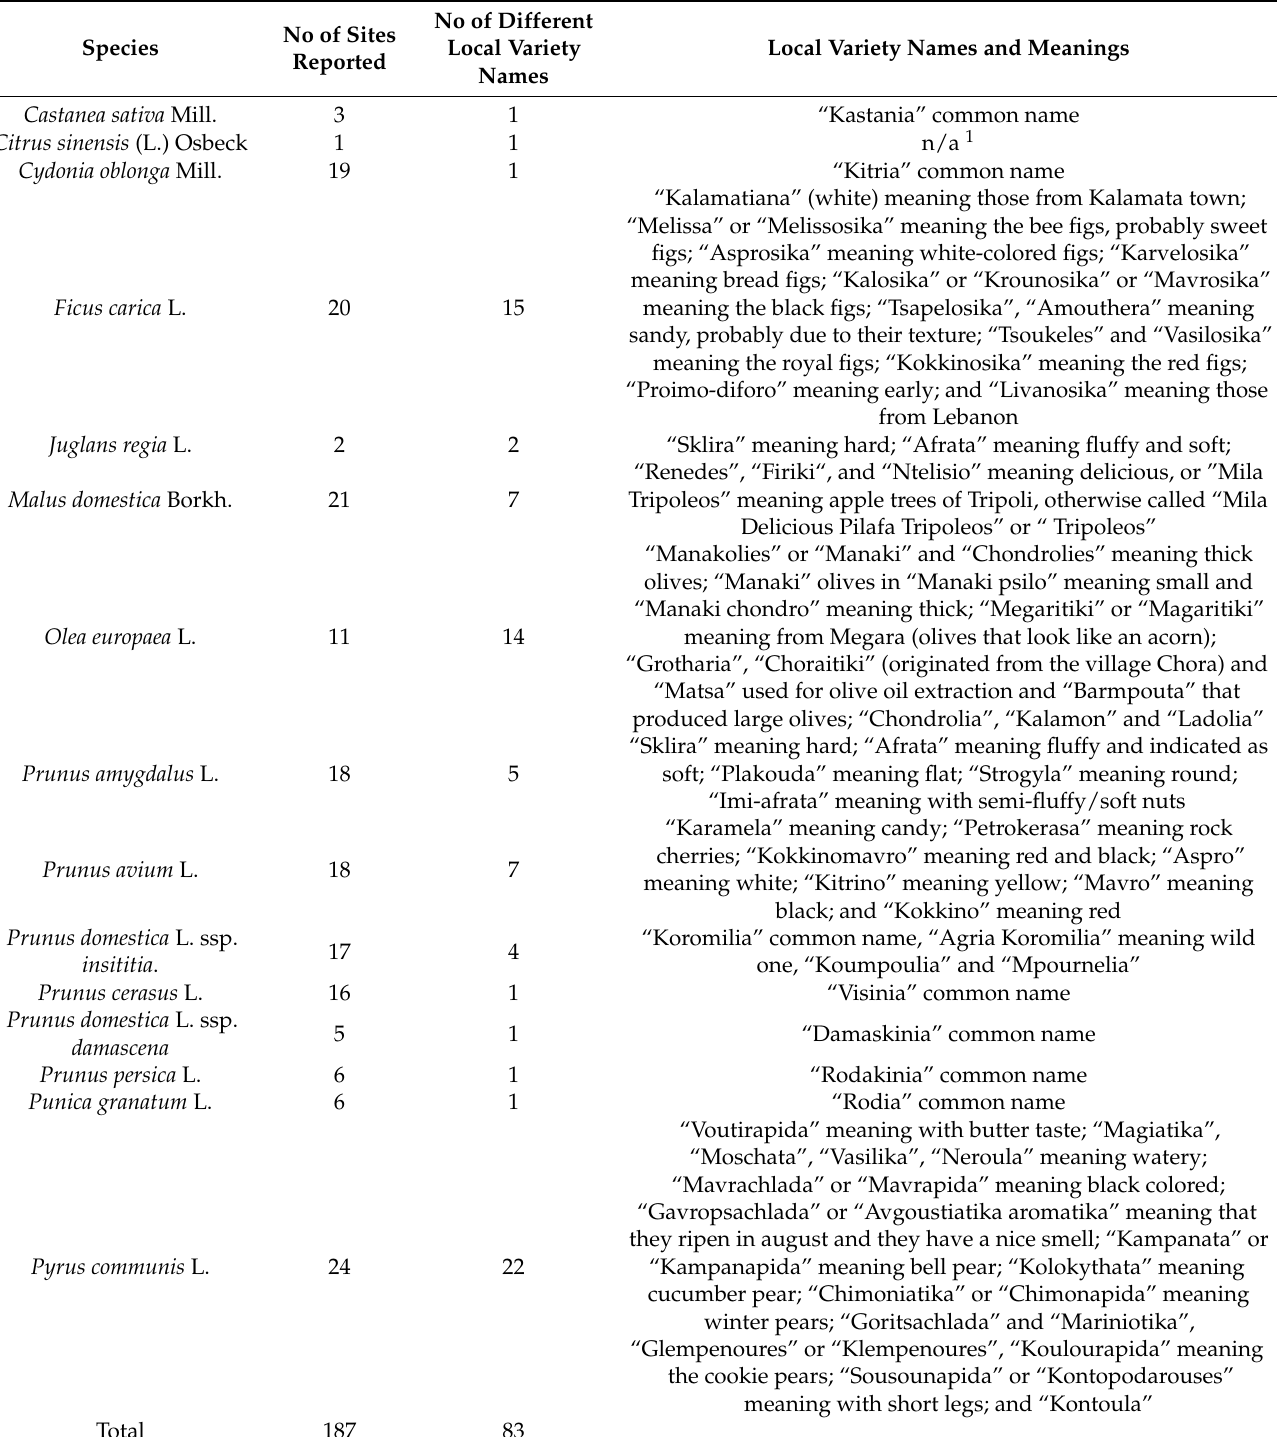
Table 7. Number of different varietal names, number of sites reported, and the meanings of the names.